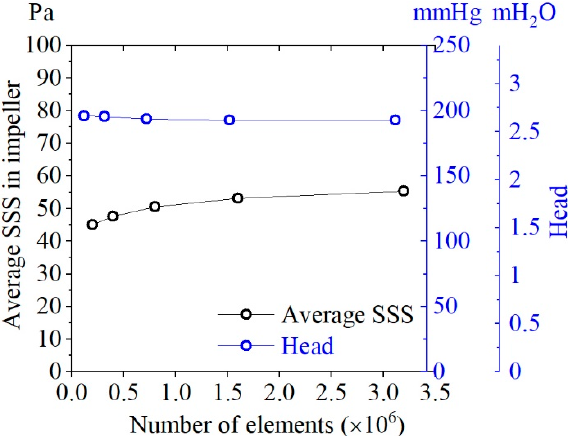
Figure 3. Grid independence test of model No. 4 with average scalar shear stress (SSS) and pressure head at the original design point ( Q 0 = 5.0 L/min, n = 2500 r/min).